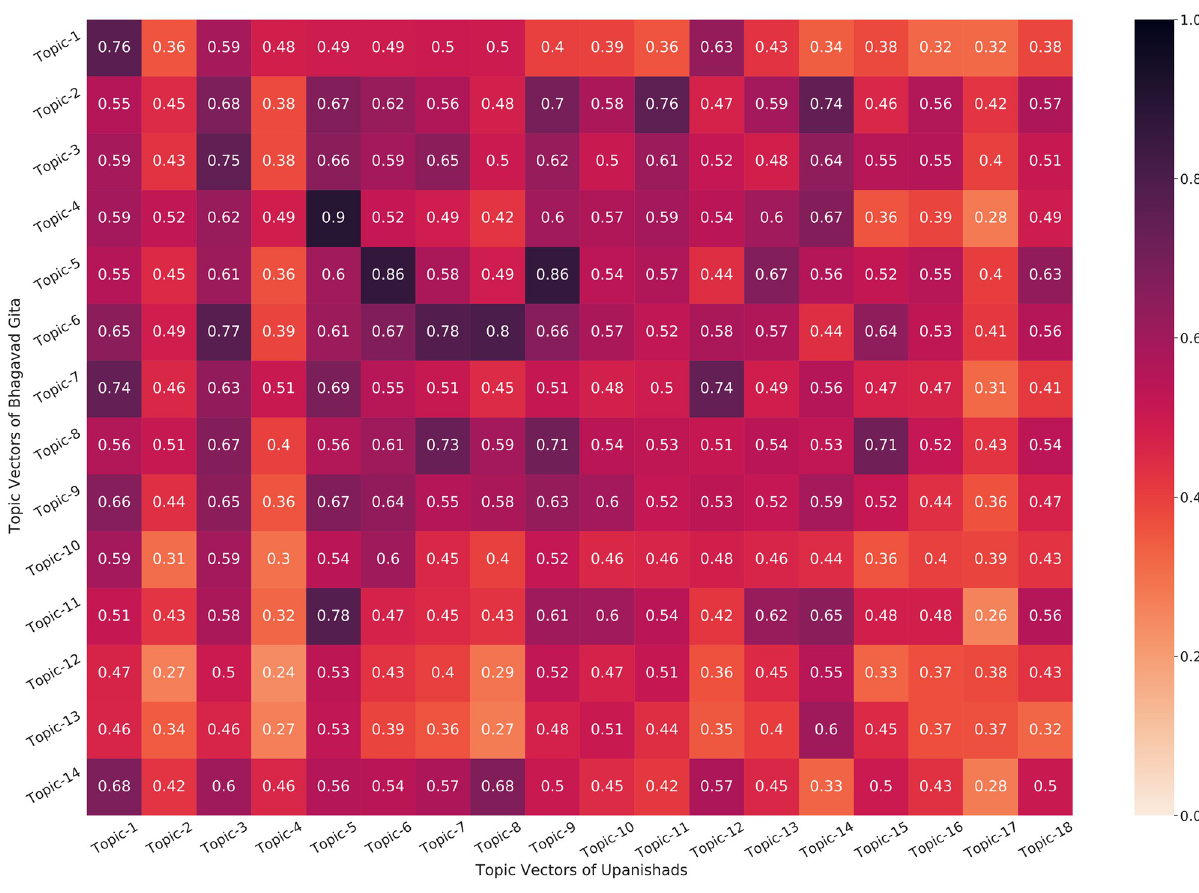
Fig 11. Heatmap showing the similarity between different topics of Bhagavad Gita (Eknath Easwaran) and Upanishads (Eknath Easwaran) generated from a selected approach (SBERT-UMAP-HDBSCAN).